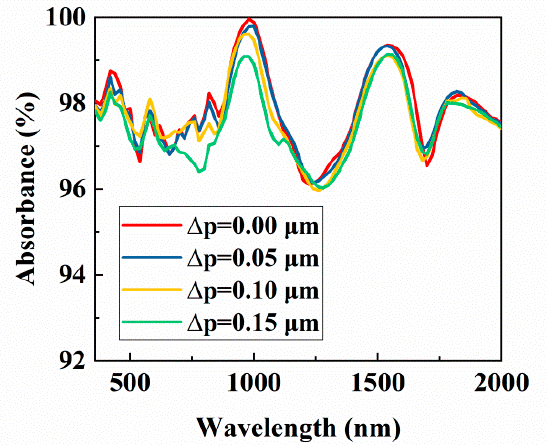
Figure 9. The measured absorbance curves of different positional deviation values ∆ p as a function of wavelength.